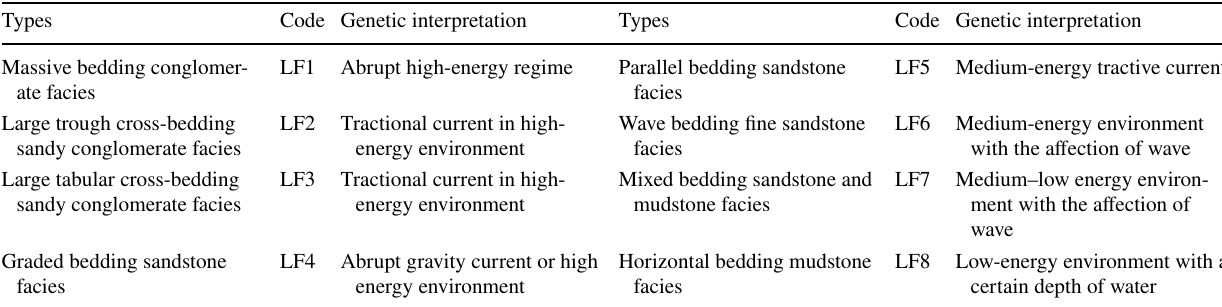
Fig. 4 Figure C–M of sandbody in Baolang oilfield Table 1 Lithofacies types and genetic interpretation of III Formation in Baobei block, Baolang oilfield